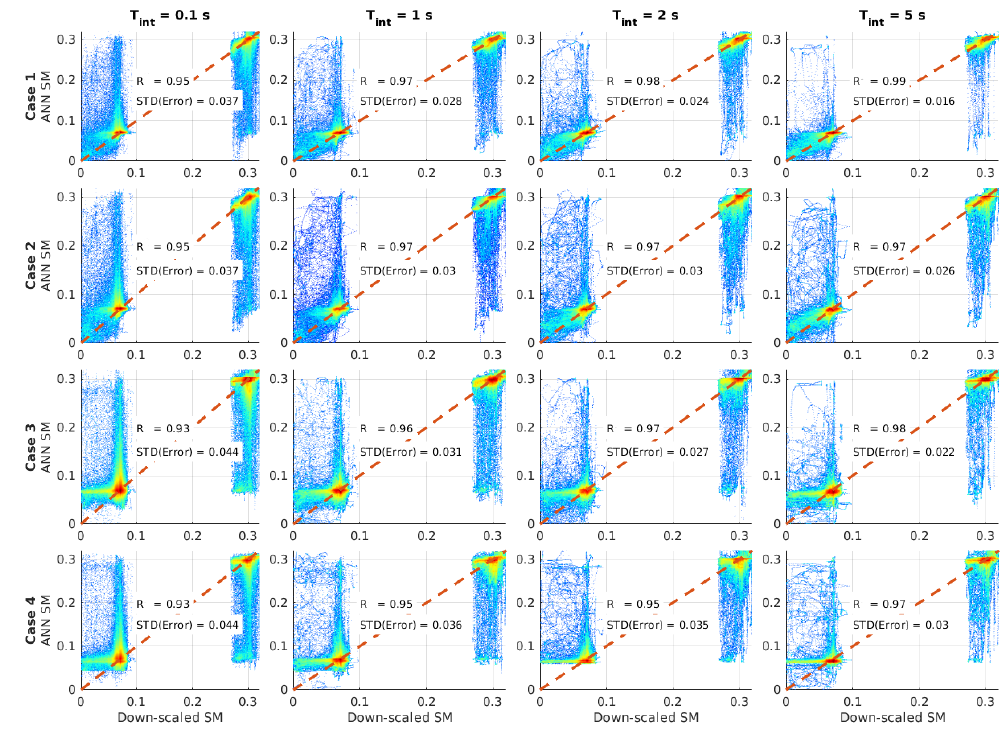
Figure 15. As for Figure 14 but for